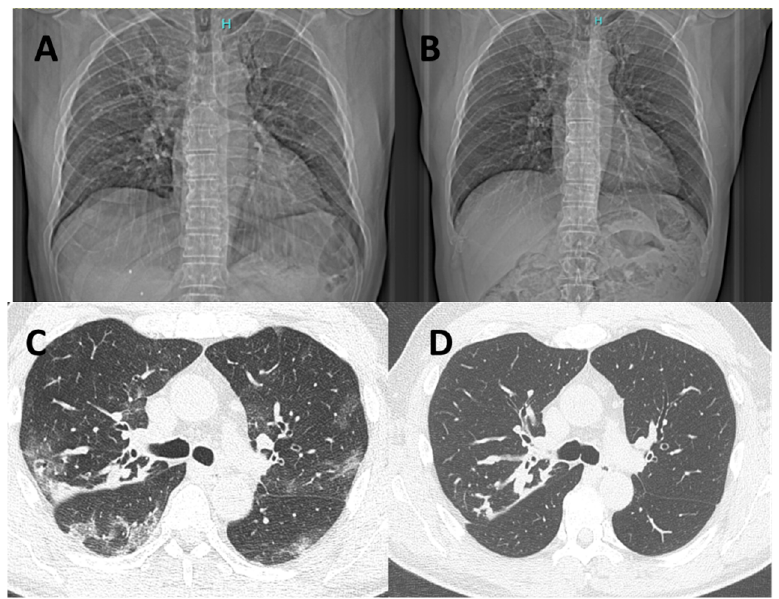
Figure 1. Chest X-ray and chest CT of a patient affected by COVID-19 in the acute phase of the disease ( left , A , C ) and after 6 months of follow-up ( right , B , D ). Chest CT shows radiological features of increased density and ground-glass opacities with peripheral and confluent distribution ( C ). The follow-up scan at 6 months documents complete resolution of COVID-related radiological findings, while peribronchial thickening and CF-related bronchiectasis remained unchanged ( D ). Table 3. Changes in pulmonary function indicators from baseline to 6 months after the RT-PCR test according to SARS-CoV-2 infection